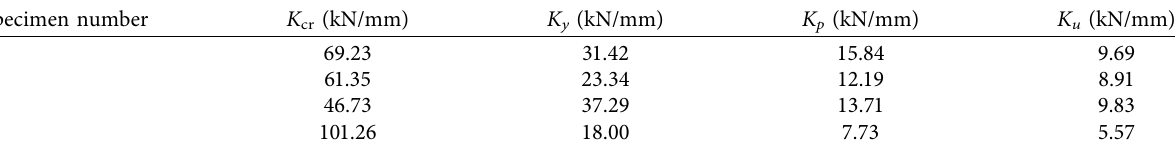
Table 3: Measured value of specimen stiffness.